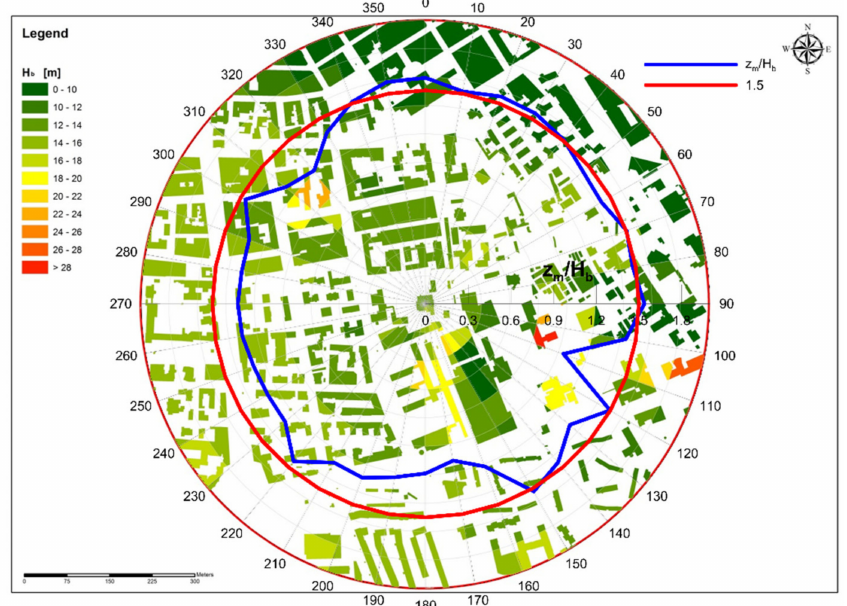
Figure 6. Color map of mean building height ( H b ) in the 324 cells around the measurement point. The ratio between measurement height and building height ( z m /H b ) as mean of all cell in a sector of 10 ◦ is represented by the blue line (values on the radius), with the reference 1.5 value traced in red for